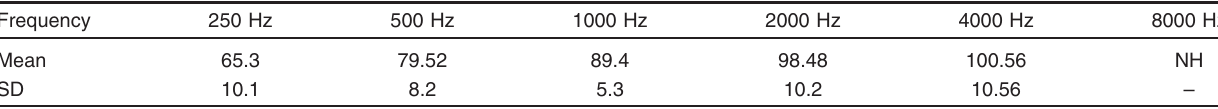
Table 1 Pure tone audiometry average in the study group Frequency